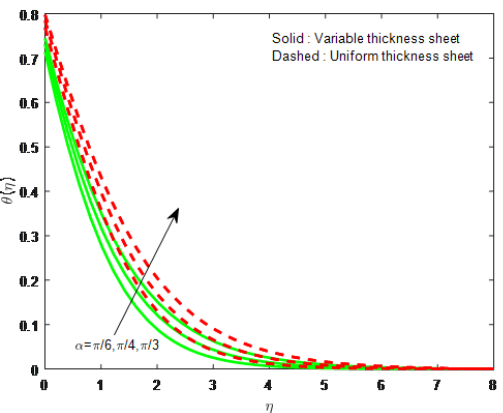
Fig. 6: Influence of α on temperature